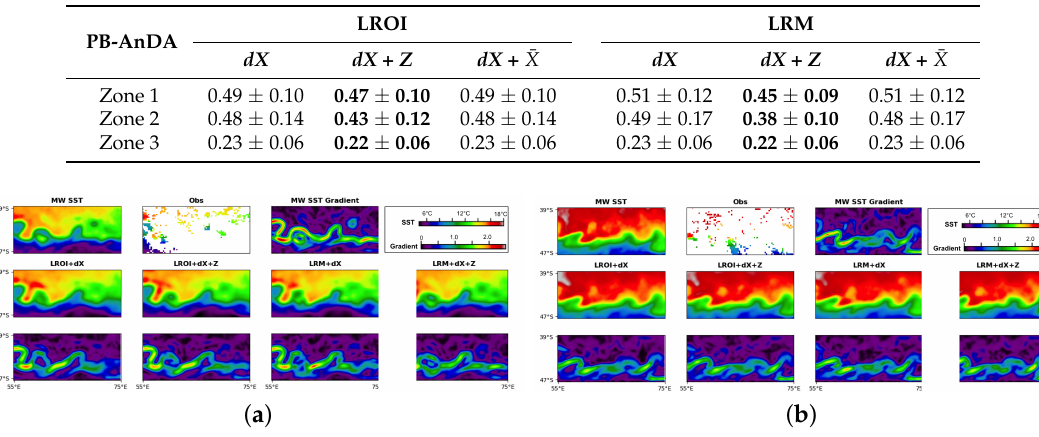
Figure 4. Comparison of assimilation results for Zone 2 and case-study MW SST for different parameterization of the PB-AnDA models: we report the example for two dates, respectively the 104th and 309th of the MW SST time series, in panels ( a , b ). For each panel, the first row depicts the MW SST field (MW SST), the cloudy SST observation (Obs) and the gradient field (MW SST Gradient). The second and third displays respectively the reconstructed SST fields and their gradient magnitude for Pb-AnDA using LROI + dX , dX + Z , LROI + LRM + dX , LRM + dX + Z